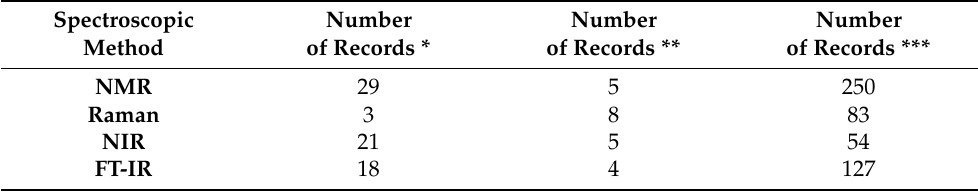
Table 1. Number of papers about using spectroscopic methods in spices adulteration and quality